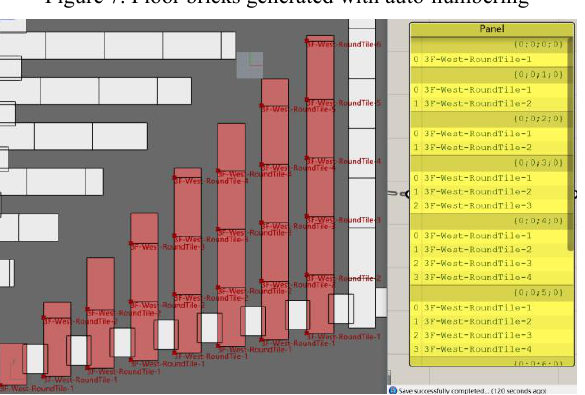
Figure 8. Roof tiles generated with auto-numbering